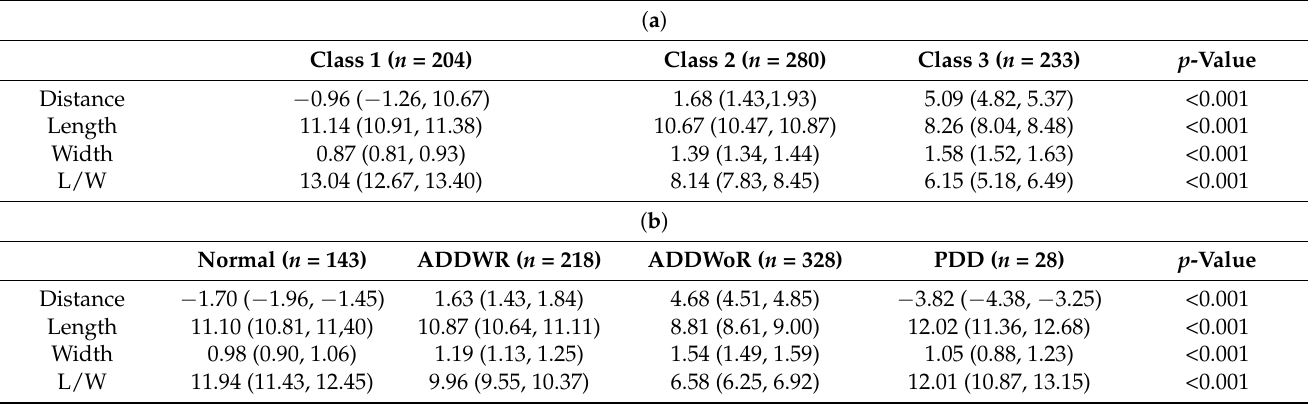
a Data in the table: adjust mean (95% confidence interval), only measurements with statistical differences are illus- trated; Distance—distance of disc displacement; L/W—length-width ratio; ADDWR—anterior disc displacement with reduction; ADDWoR—anterior disc displacement without reduction; PDD—posterior disc